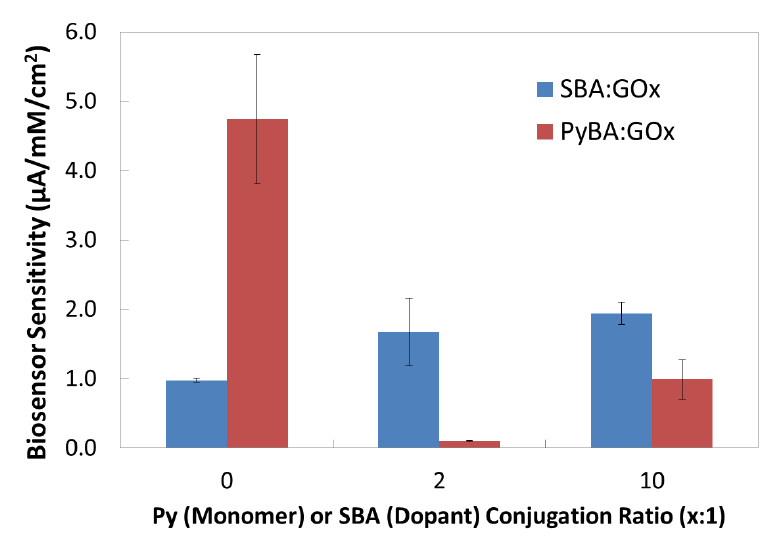
Figure 6. Effects of the extent of monomerization and sulfonization via increasing molecular ratio of PyBA or SBA to GOx on biosensor